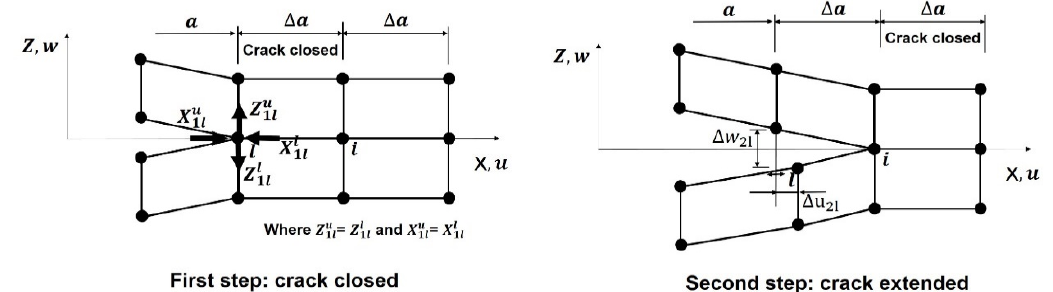
Figure 15. Two-step crack closure method